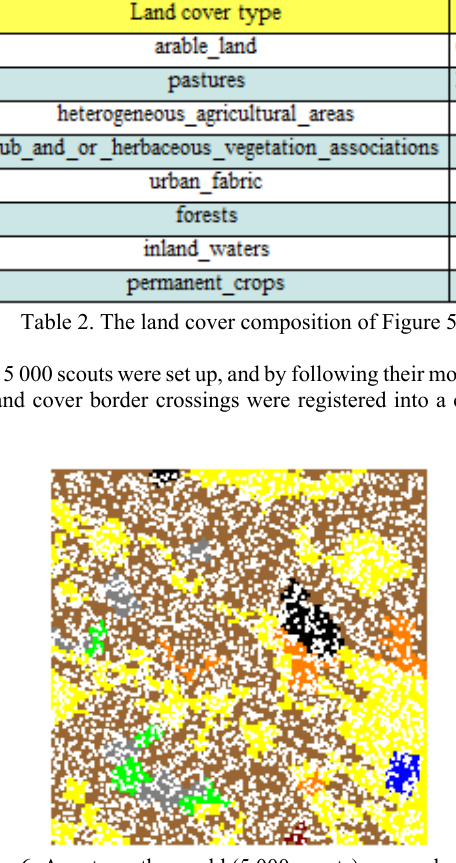
Figure 6. Agents on the world (5 000 scouts), we analysed their paths through 20 time epochs. The agents step size length was fixed to one cell width.